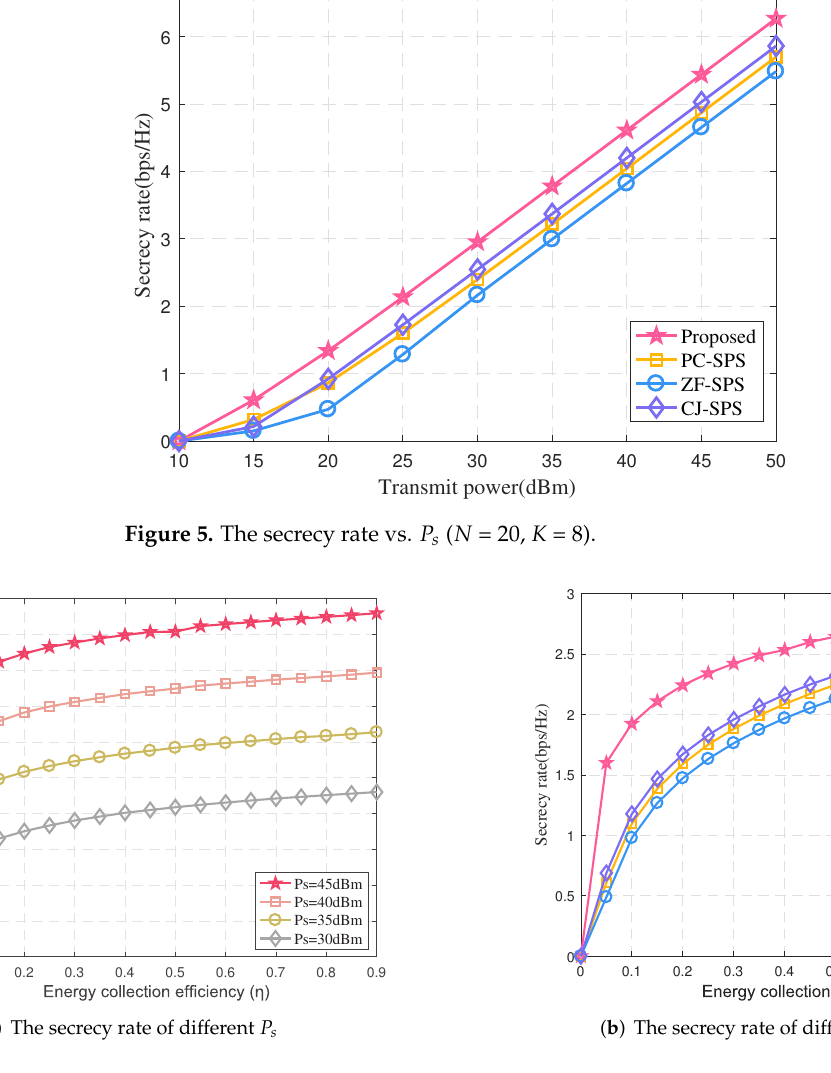
Figure 6. The secrecy rate vs. η ( N = 15, K =